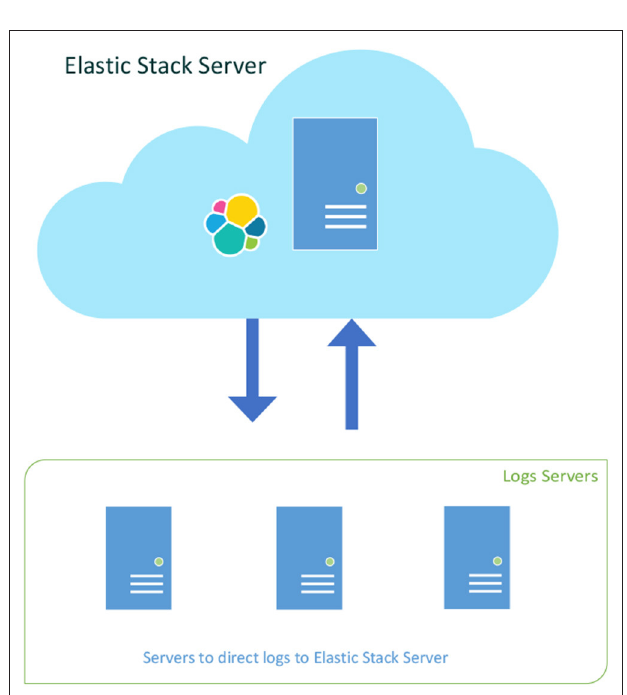
FIGURE 3 | Three log servers sending their logfiles to the Elastic Stack Server.